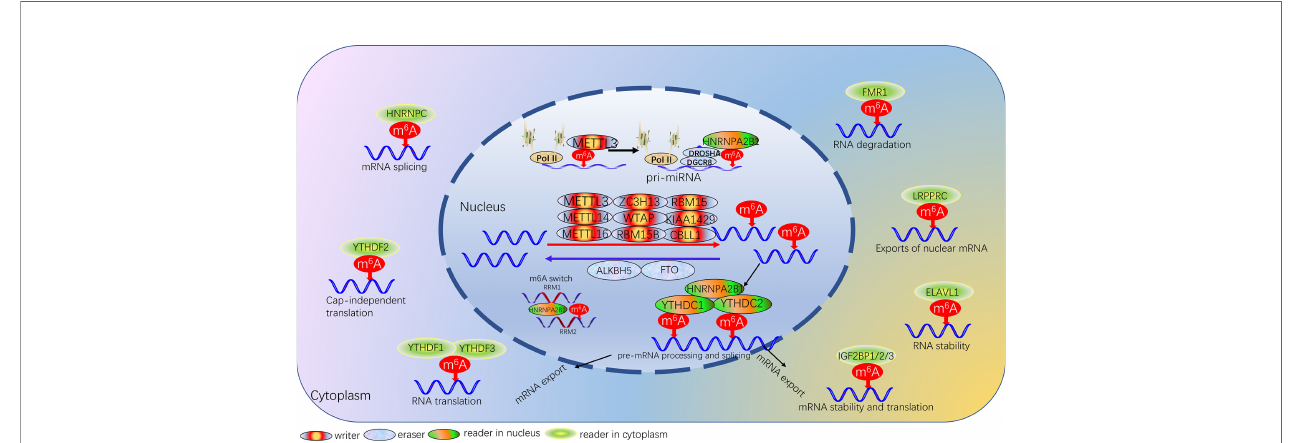
FIGURE 1 | Landscape of dynamic and reversible processes of m6A RNA methylation mediated by 24 regulators and their potential biological functions